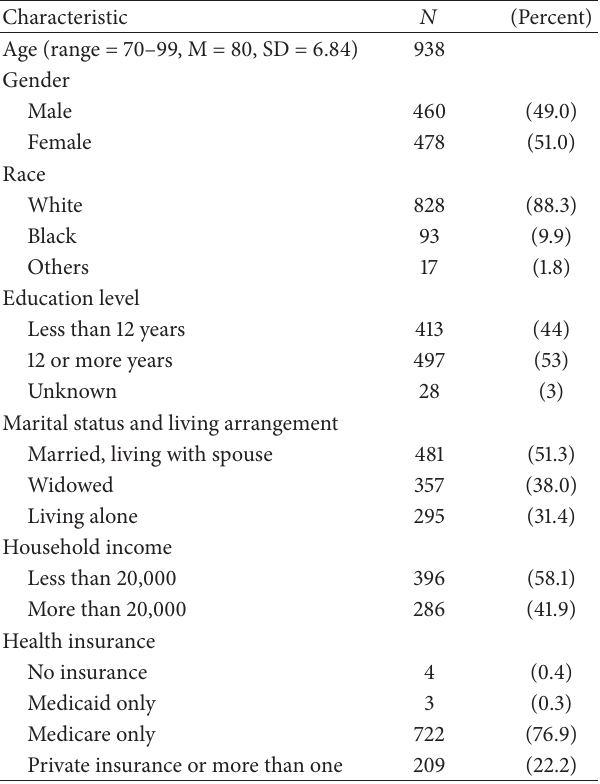
Table 1: Demographic characteristics ( 𝑁 = 938